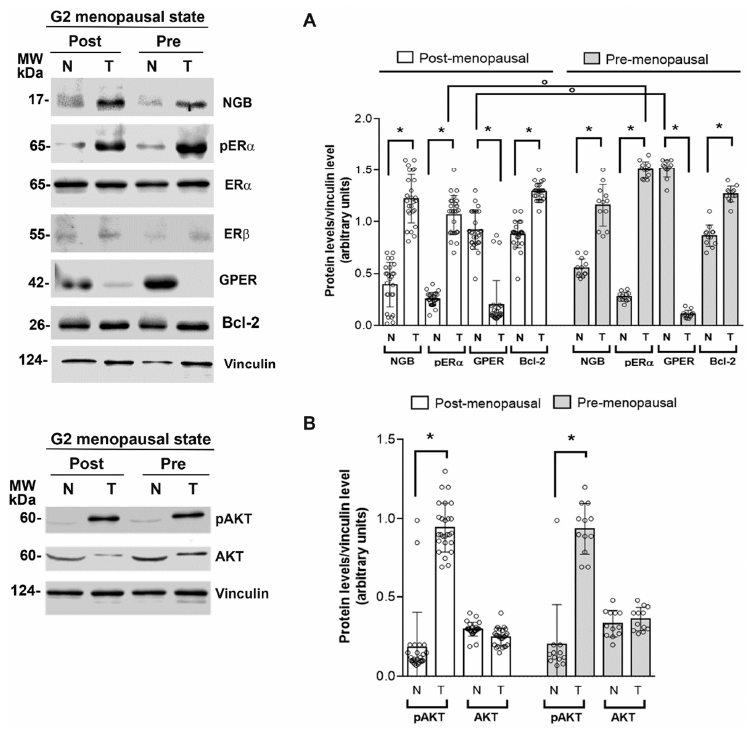
Figure 2. Association between NGB levels and estrogen receptors in breast cancer tissue. Representative Western blot images of NGB, pERα, ERα, ERβ, GPER, Bcl-2 protein levels ( A ) and AKT levels and activation ( B ) in G2-grade post- ( n = 26) and pre-menopausal ( n = 12) specimens of breast cancer (T) and their normal counterpart (N). The amount of protein was normalized by comparison with vinculin levels. Data are the mean ± SD. p < 0.001 was calculated with Student’s t-test with respect to the normal or tumoral (e.g., GPER) counterpart (*) and vs. the same parameter on the post-menopausal sample (°).